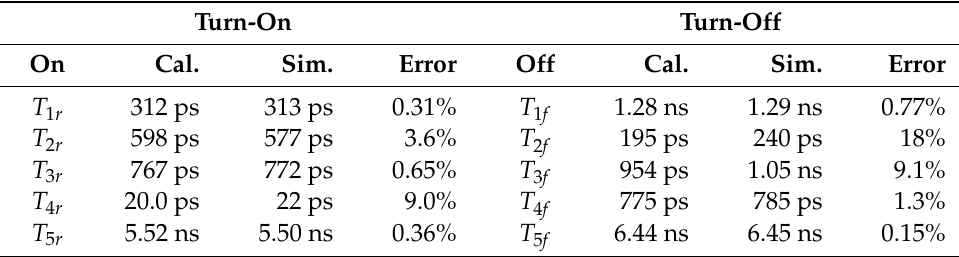
Figure 5. Simulated switching waveforms of V GS , I ch , and V DS in a capacitance-limited case. Table 4. Calculation and simulation results of switching interval